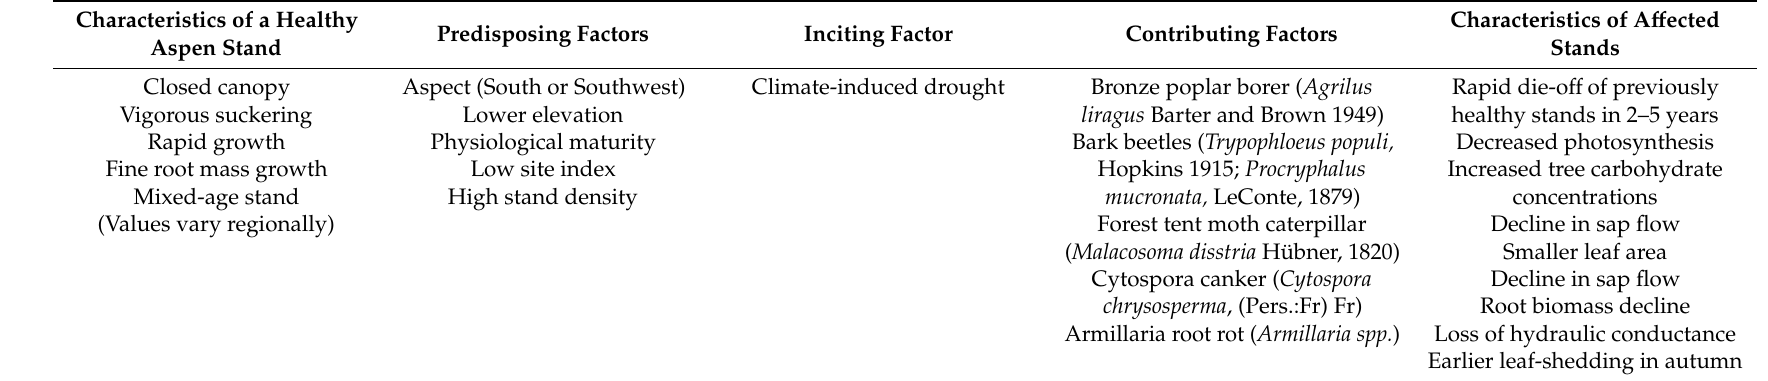
Table 1. We list the various predisposing, and contributing factors of SAD, which synergize to transform a healthy aspen stand into sudden decline and dieback. These parameters are derived primarily from Frey et al., [7]; but modified by more recent information from work by Worrall et al., [12], Anderegg et al., [13], and Morelli and Carr [5], with supporting information from Petty